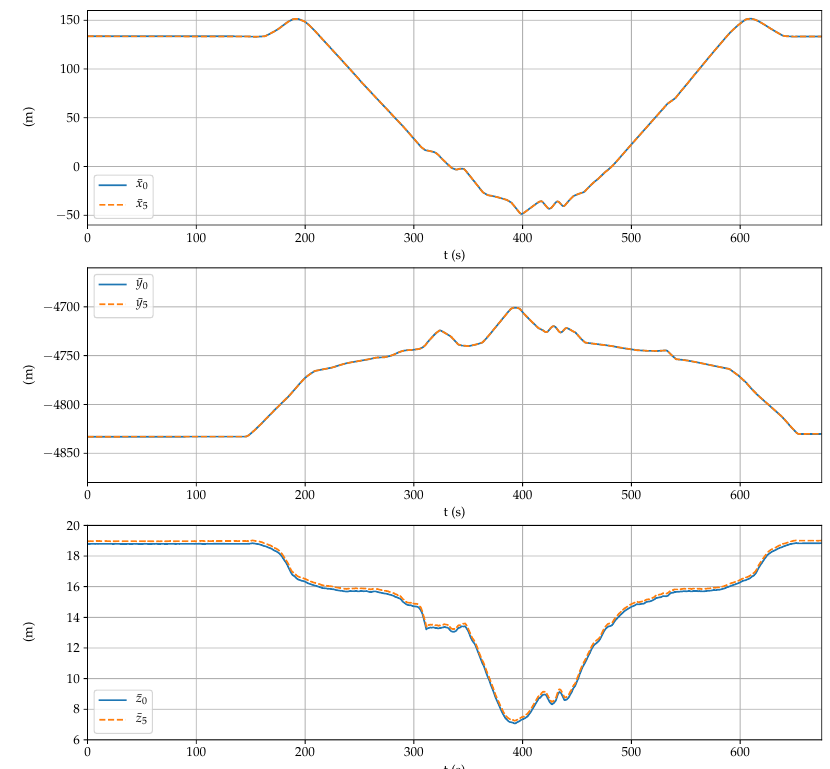
Figure 12. Comparison between the position coordinates obtained by the fifth receiver and the proposed sensor.